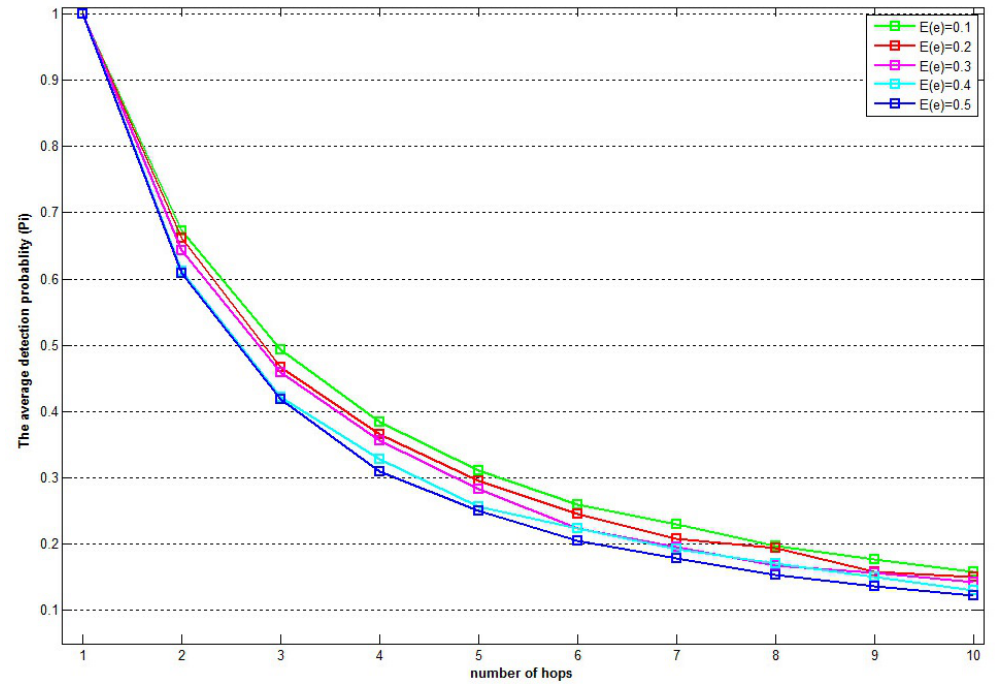
Figure 12. The effect of cluster size on the detection probability of the D-IDS for various packet loss rates while the sleep rate is